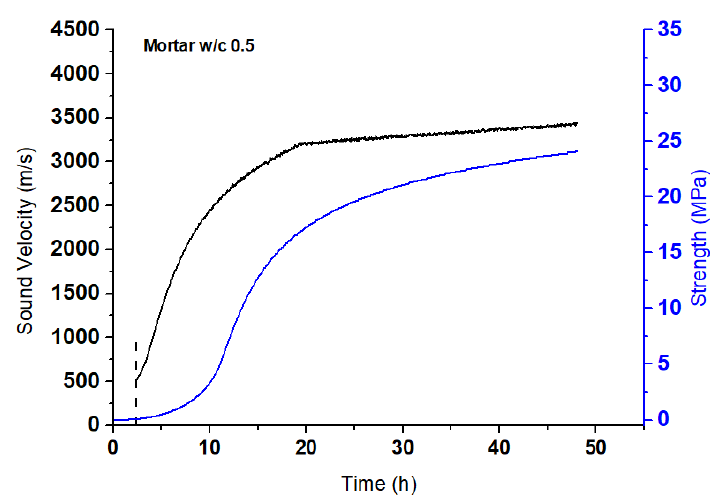
Figure 5. Sound velocity during the hardening process of mortar with ratio w/c 0.5. The first waveforms are detectable as soon as the strength ceases to be zero.